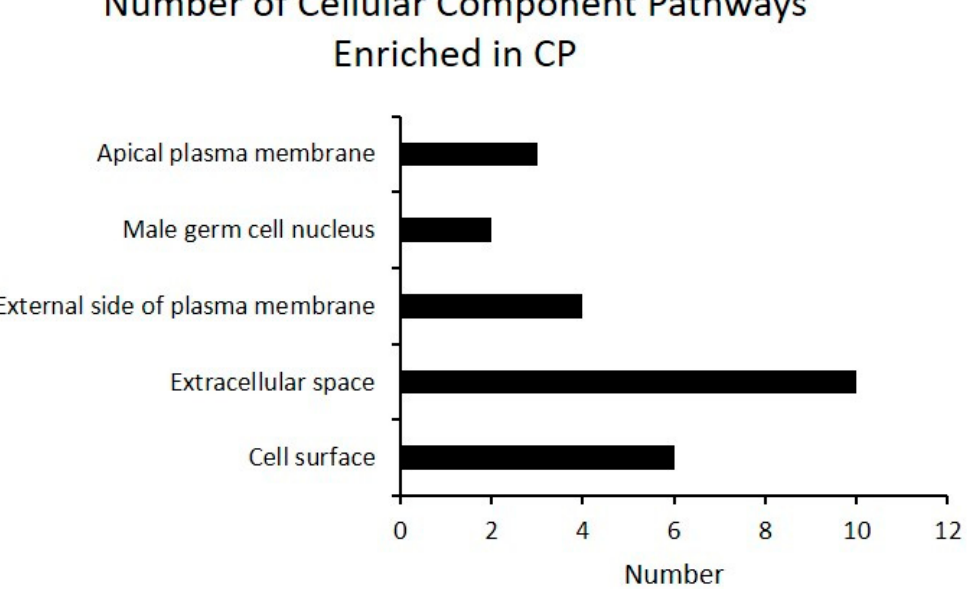
Figure 5. Gene ontology (GO) analysis of differentially expressed genes highly expressed in BP ( A ) and CP ( B ). The identified differentially expressed genes were classified into cellular components. The number of genes in the GO term is shown above (BP vs. CP; CP: cross-bred commercial pigs, BP: Large Black pigs).